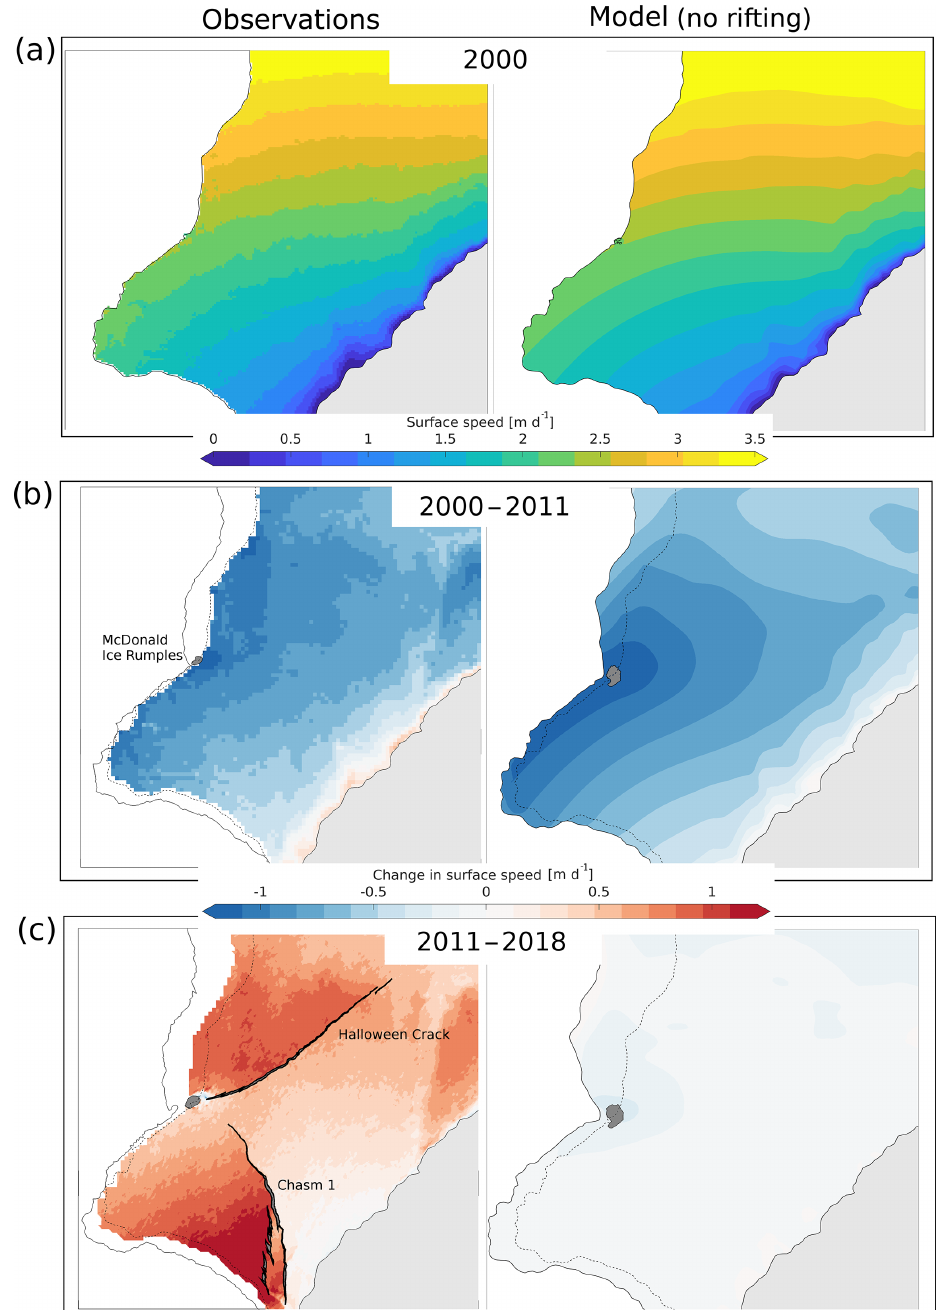
Figure 4. Comparison between observed (left column) and modelled (right column) surface speed of the Brunt Ice Shelf between 2000 and 2018. The 2000 ice front location is shown by the dashed lines and the extent of the McDonald Ice Rumples is shaded in grey. Observations and model simulations broadly agree in 2000, and both show a significant slowdown between 2000 and 2011 due to increasing contact between the ice shelf draft and a seabed shoal at the McDonald Ice Rumples. However, observations and model simulations strongly diverge after the formation and propagation of Chasm 1 (2012) and Halloween Crack (2016). This difference is because Chasm1 is not generated within the numerical model due to the model’s lack of a fracture mechanical component. This situation is typical for current generation of large-scale ice shelf models. Here, these differences lead to ice flow speed being underestimated by more than 1md − 1 (or up to 100%) at the end of a transient run over less than a